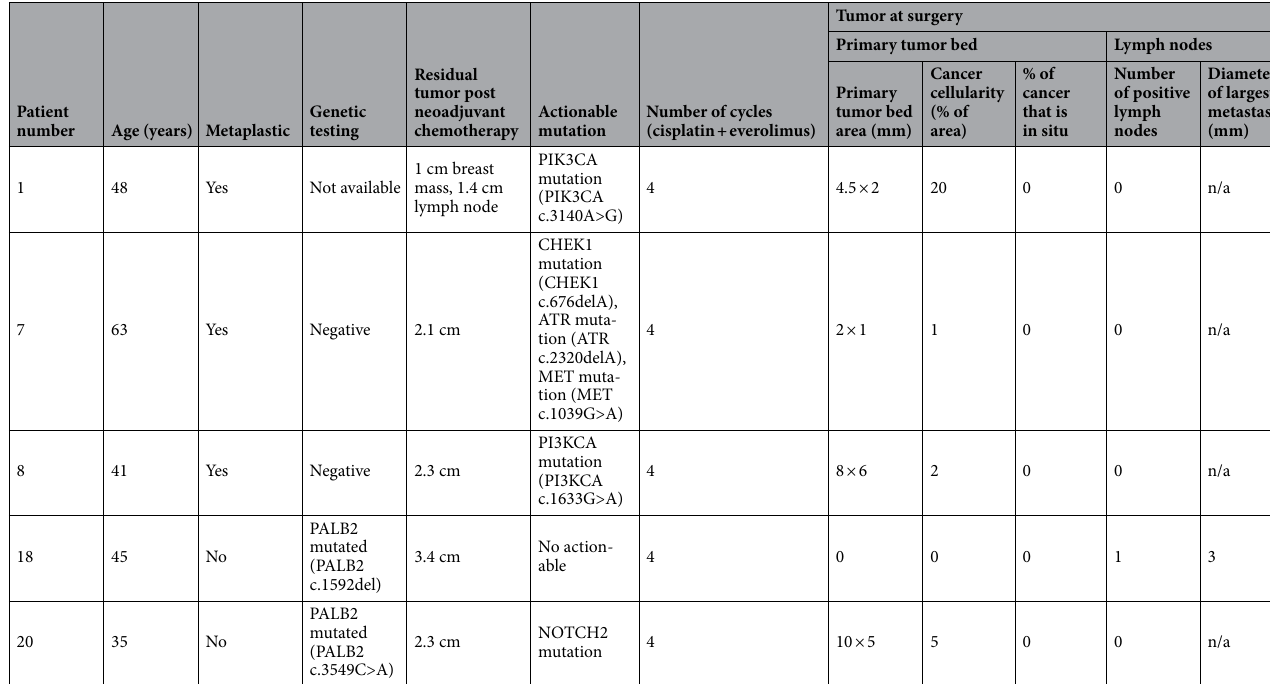
Table 3. Characteristics of patient achieving RCB-I at surgery post cisplatin plus